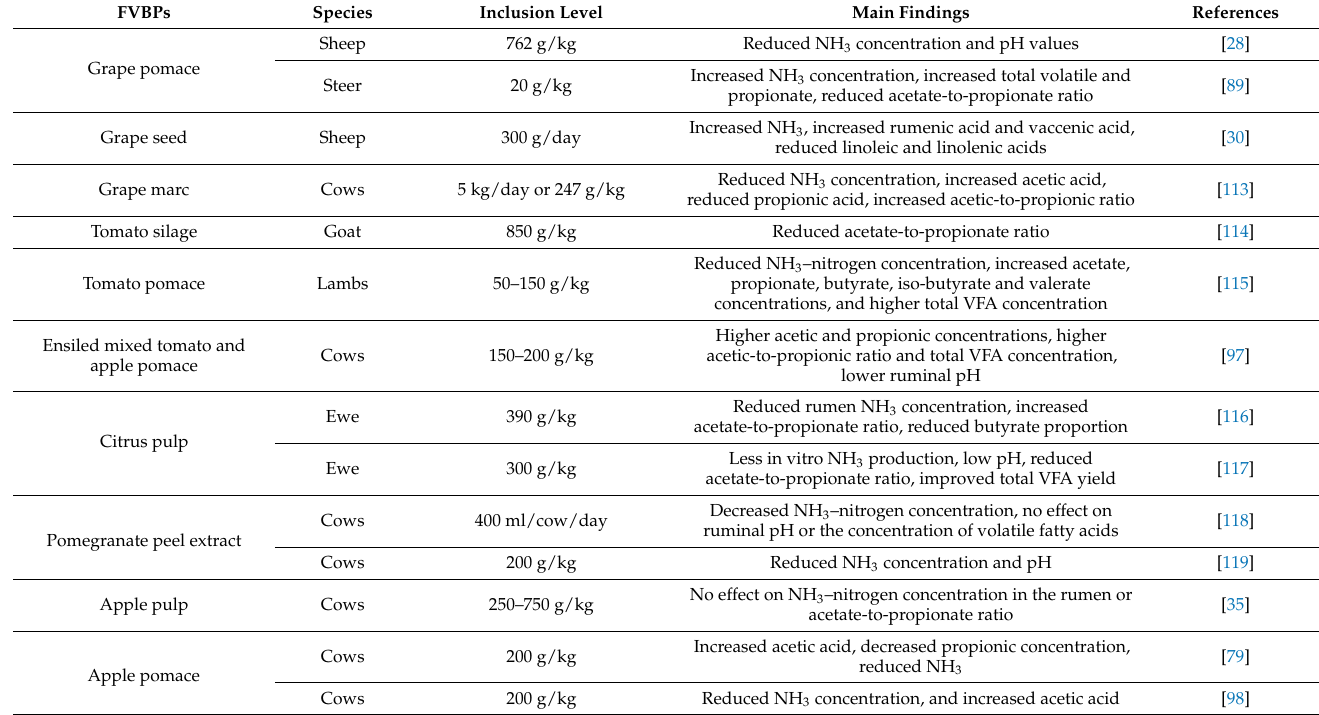
Table 4. The effects of feeding FVBPs on rumen fermentation